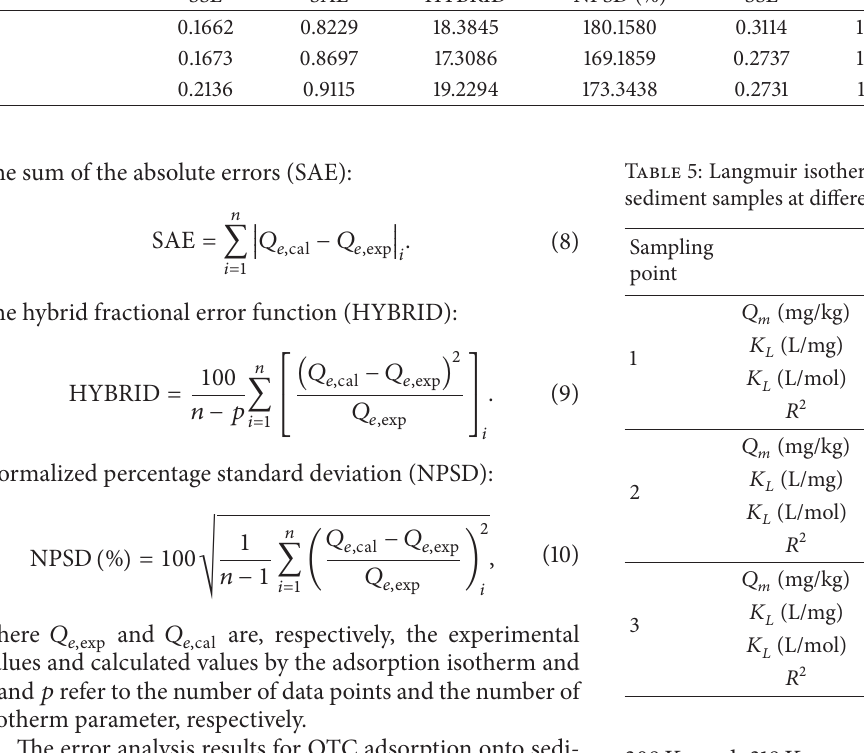
Table 4: Isotherm simulated results with error analysis for OTC adsorption onto sediment samples. Sampling point